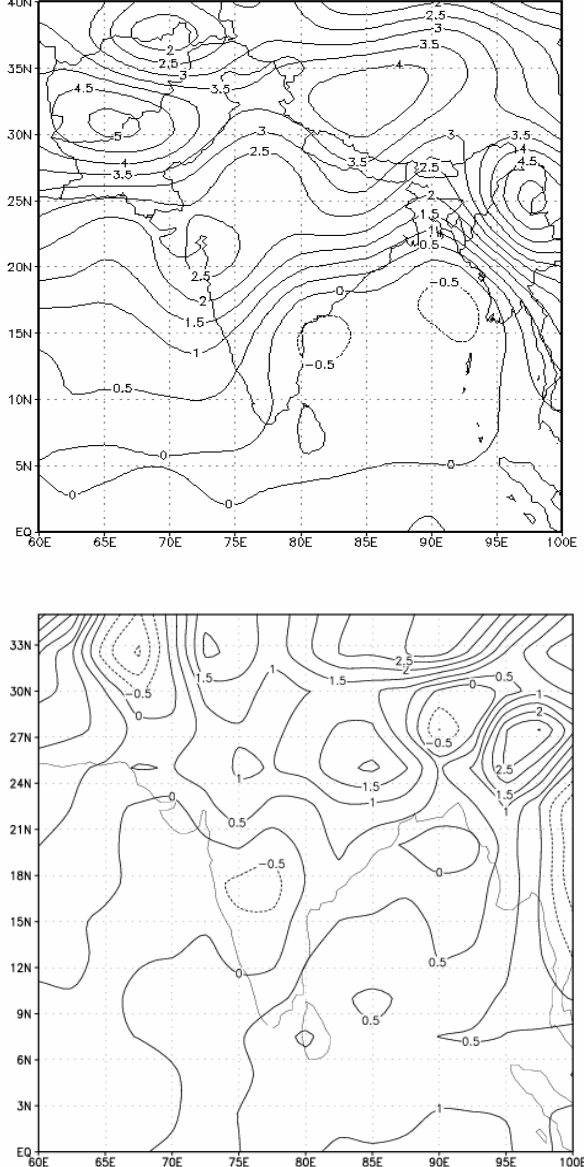
Figure 1 Fig. 1. Spatial distribution of anomalies of the surface temperatures ( ◦ C) during March 2004 (top panel) and March 2005 (bottom panel) over the Indian subcontinent